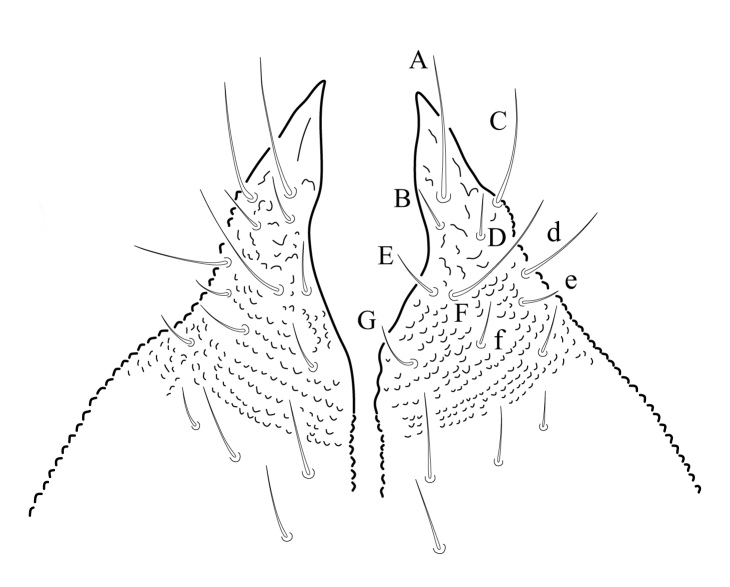
Labium chaetotaxy